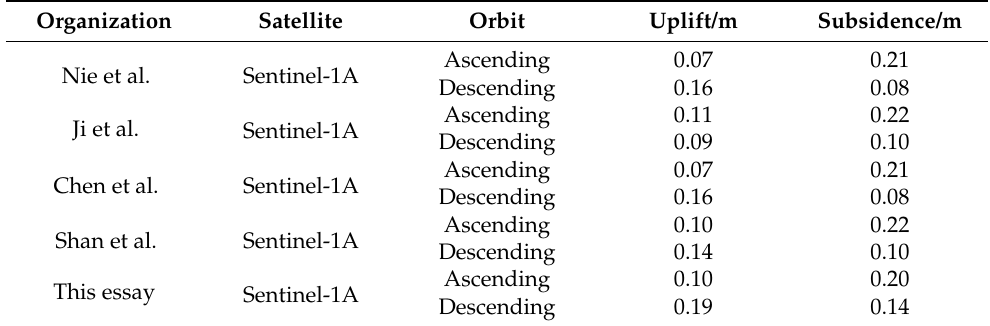
Table 4. Results of line-of-sight deformation of Jiuzhaigou earthquake by different